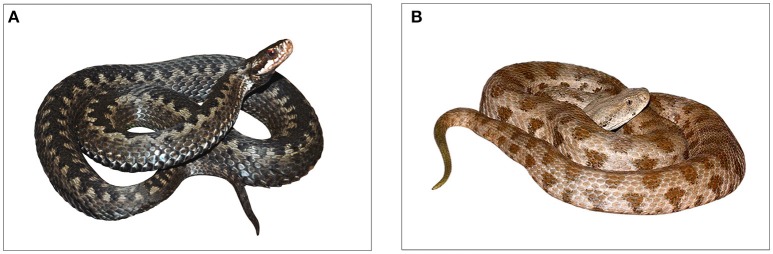
The most dangerous species of venomous snakes in each country: (A) the common European adder (V. berus) from the Czech Republic, original photo Pavel Kirillov, standardized version; (B) the Levant viper (M. lebetina) from Azerbaijan, original photo Omid Mozaffari, standardized version. We predict that these snakes should elicit the highest fear in the Czech Republic and Azerbaijan, respectively.